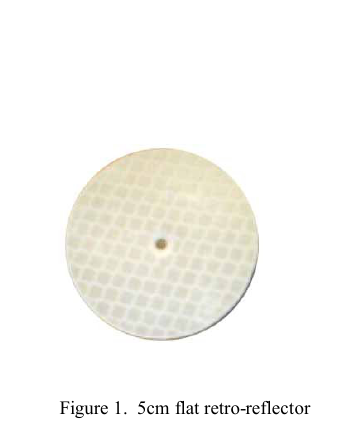
 Range figure : this shows the distance from the target to the